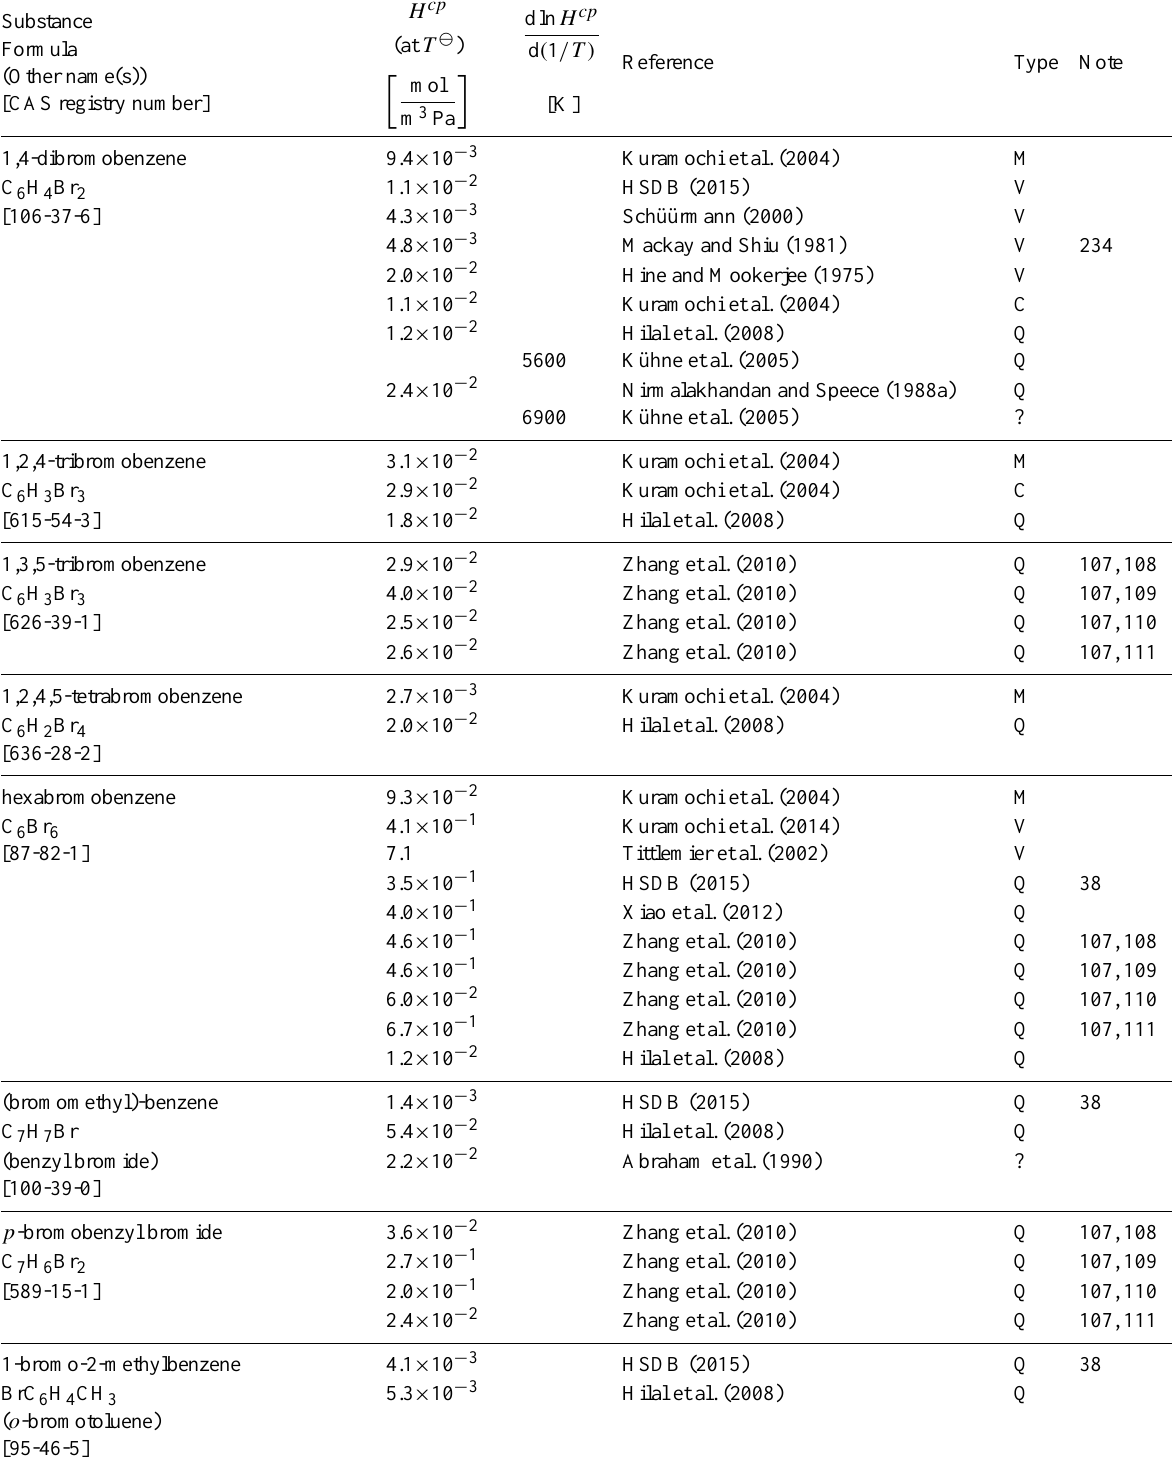
Table 6: Henry’s law constants for water as solvent